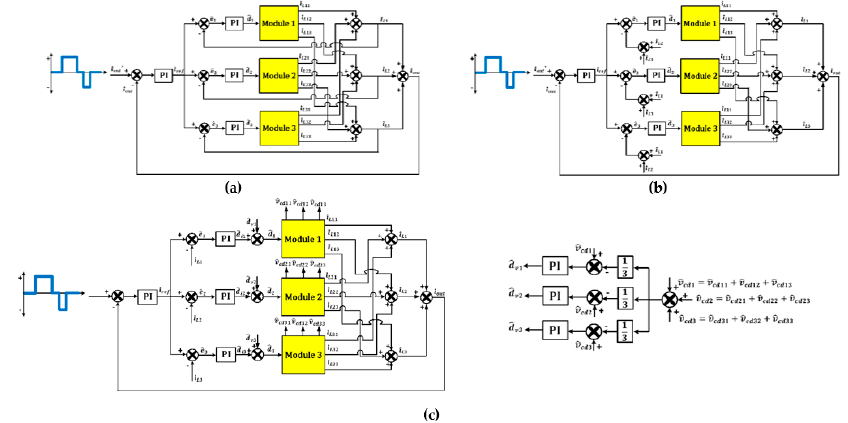
Figure 9. Control schemes for the four DC-DC converters; ( a ) control scheme used for input parallel-connected systems; ( b ) control scheme used for ISOP DC-DC converter; ( c ) control scheme used for ISOS DC-DC converter.